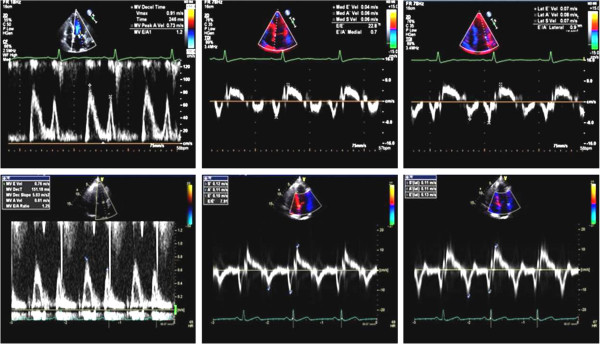
Representative figures of a subject with concordance (upper 3 figures) and discordance pattern (lower 3 figures) of tissue Doppler imaging.